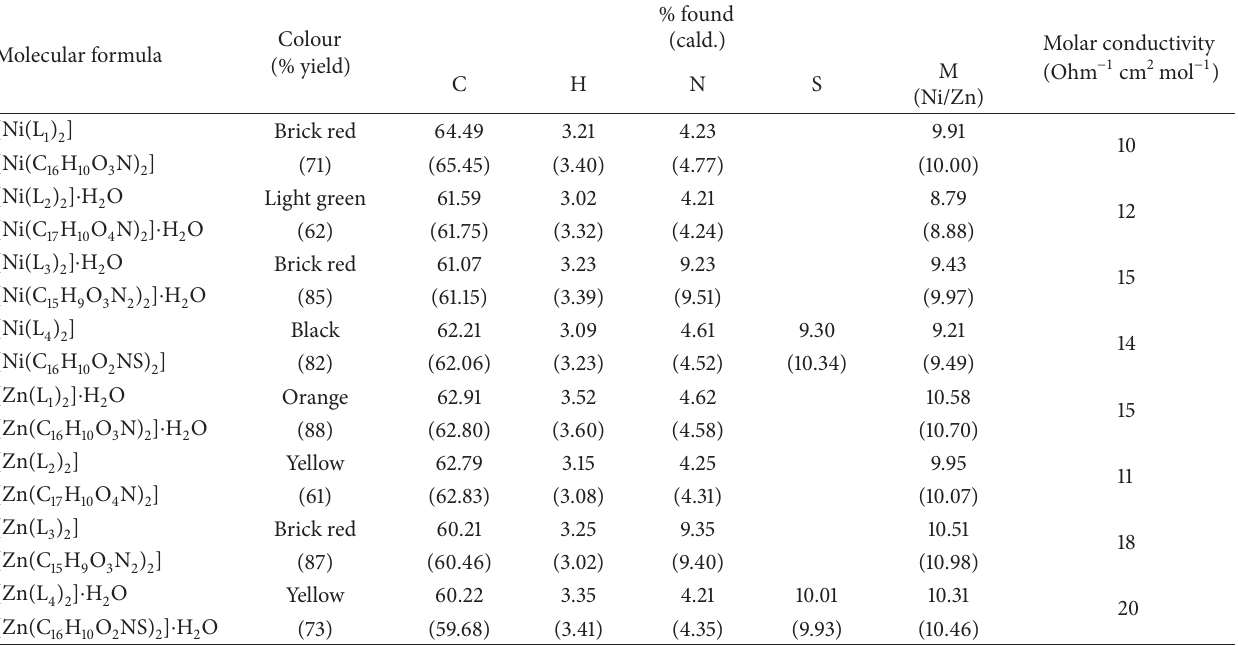
Table 1: Elemental analysis and physical properties of metal complexes.